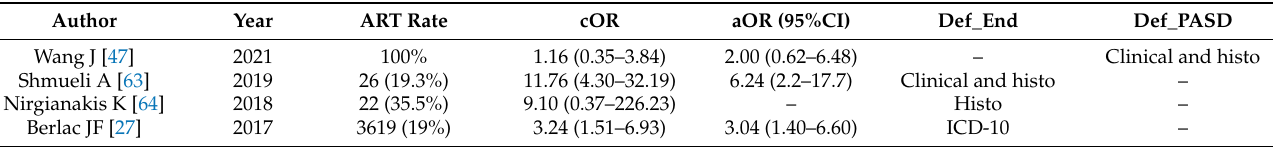
Table 2. Effect of endometriosis on the prevalence of placenta accreta spectrum.